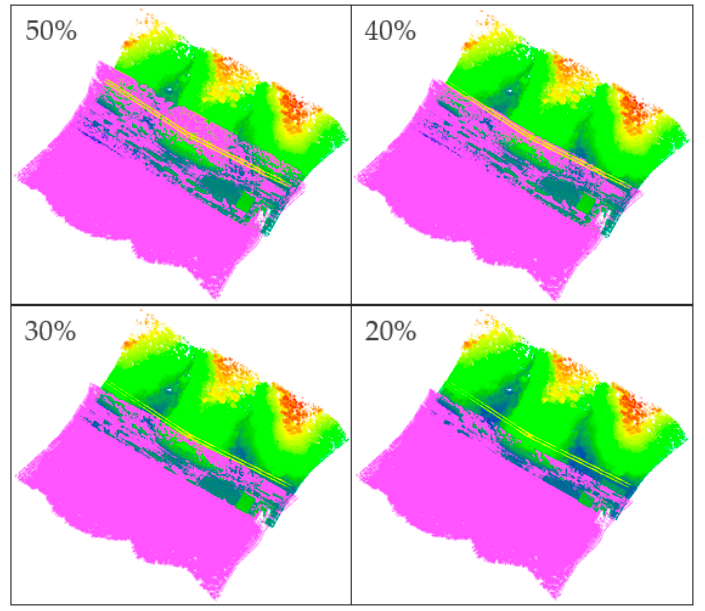
Figure 9. Registration results of different degrees of overlap. The colored point cloud displayed by elevation is Strip 3, and the purple point cloud is Strip 6. Table 3. RMSE calculation results before and after